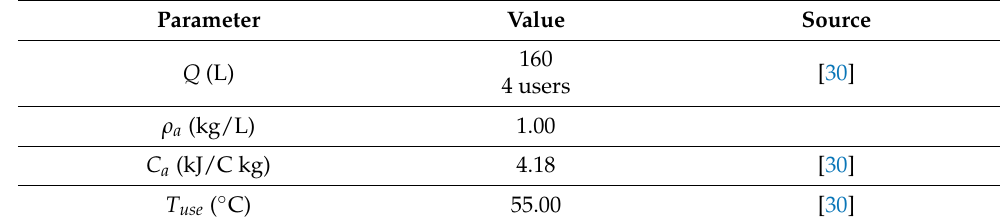
Table 10. DHW demand for the city of Cuenca and required equipment.